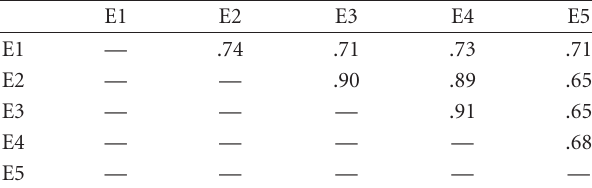
Table 3: Concordance ratio of each evaluator’s result.